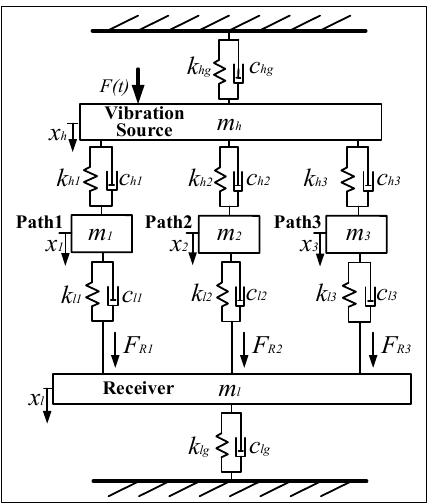
Figure 1. Transfer path model of single-degree-of-freedom vibration system.